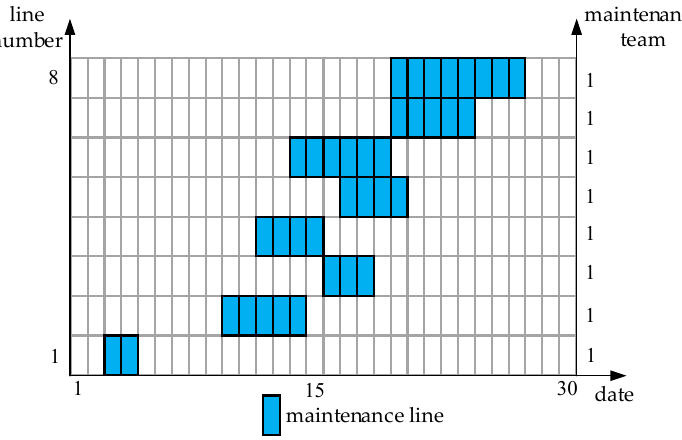
Figure 3. Overhead transmission line maintenance scheduling and resource arrangement.